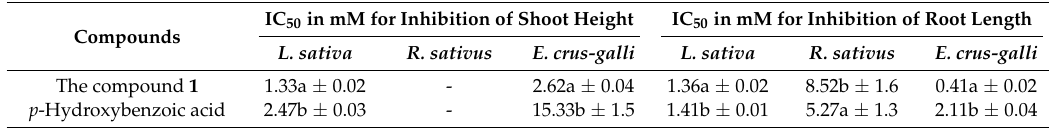
Table 4. Inhibitory potential of 2 α ,3 β ,7 β ,23-tetrahydroxyurs-12-ene-28-oic acid on shoot height and root length of L. sativ a, R. sativus, and E. crus-galli, compared with p -hydroxybenzoic acid. IC 50 in mM for Inhibition of Shoot Height Compounds